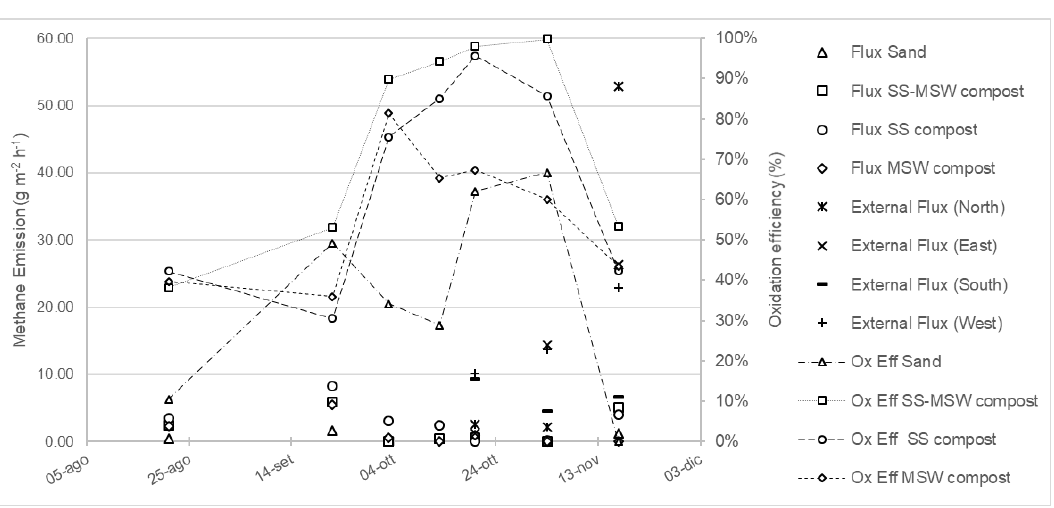
Figure 6. Methane emission measurements.